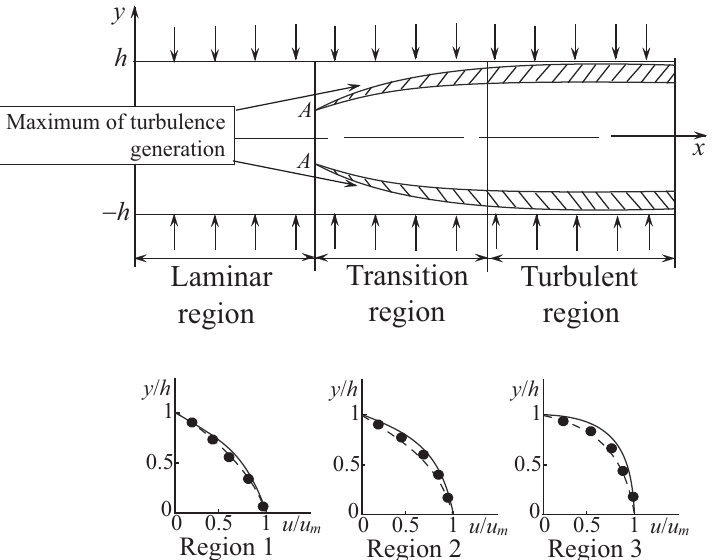
Figure 12. Flow regimes in the channel with fluid injection and comparison of the velocity profiles predicted with the inviscid model (dashed lines), the viscous model (solid lines) and the experiments from [2] (symbols •